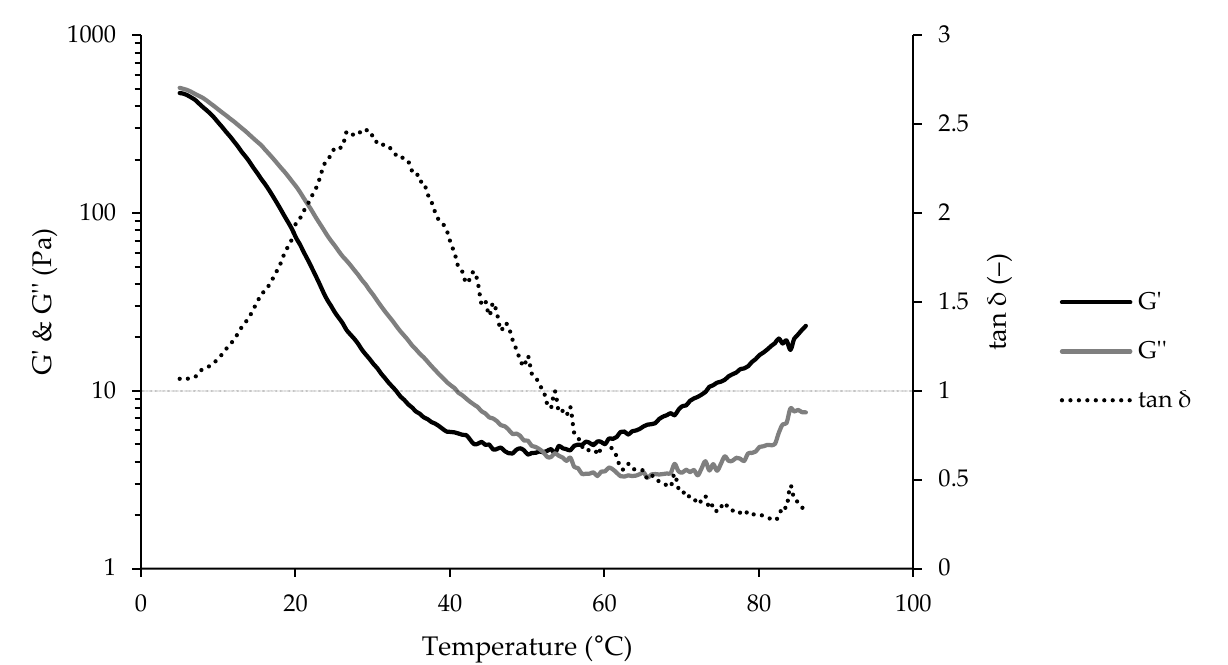
Figure A6. Temperature sweep: Storage modulus G′, loss modulus G″ , and loss tangent tan δ of a single measurement of a full fat sample as an example curve for dynamic oscillatory rheological analysis.